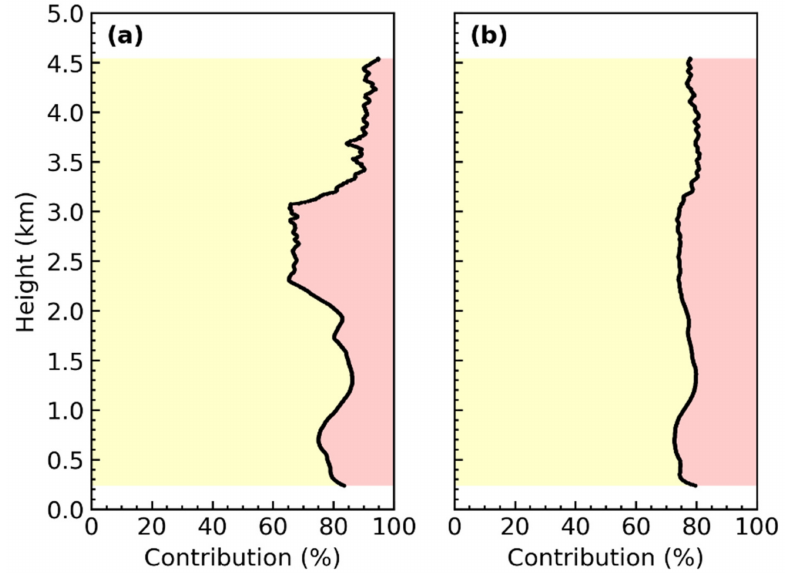
Figure 8. The average relative contributions of dust (yellow shade) and urban haze (red shade) mass concentrations in total mass concentrations ( a ) on 1 October, and ( b ) from 24 September to 3